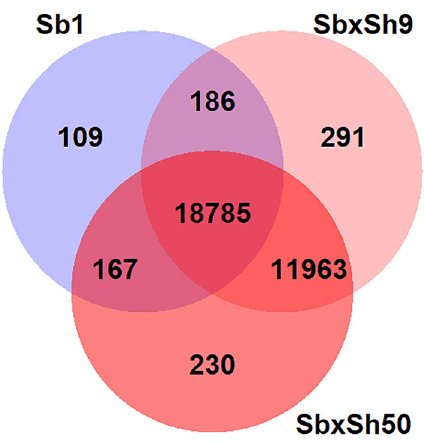
Figure 4. Number of shared and private genes among Sb1 (IESV 99,091 DL) and two sister perennial RILs (SbxSh9 and SbxSh50) derived from SbxSh cross backcrossed (2 recurrent parent doses: Tx623*2/Gypsum 9; BC1) to S. bicolor 74